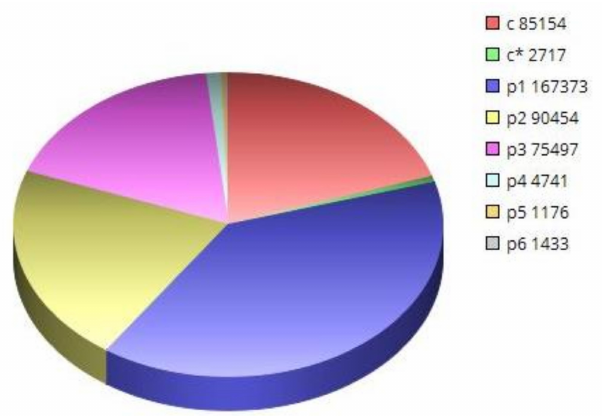
Figure 1. Distribution of SSR motif types in the reference pea genome sequence. c —compound motifs; c* —compound interspersed motifs; p —perfect motifs. P1 to P6 represent the perfect motifs with 1 to 6 nucleotide